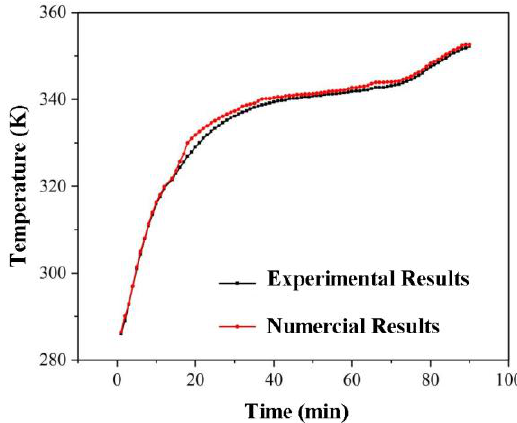
Figure 6. Comparison of experimental and simulation results.